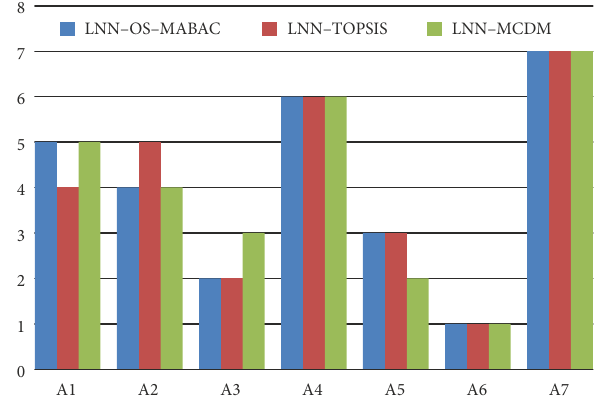
Figure 6. Comparison of the ranks of the alternatives according to different